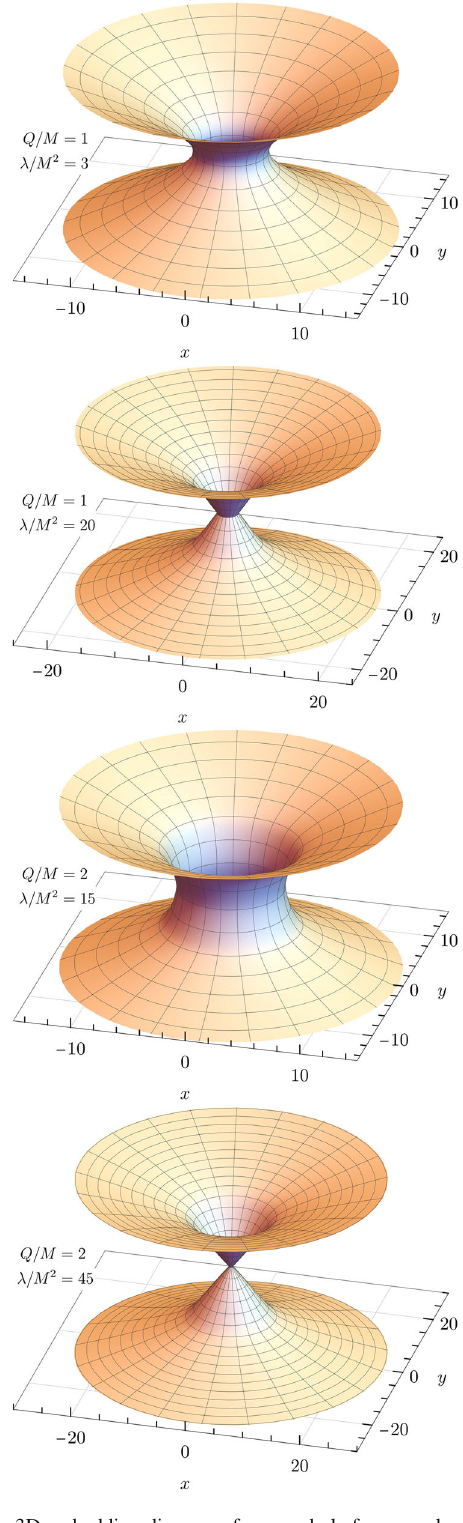
Fig. 23 3D embedding diagram of a wormhole for several parameter valuesof Q / M and λ/ M 2 forcouplingfunction(i).Theproperdistance between adjacent horizontal grid lines is 2